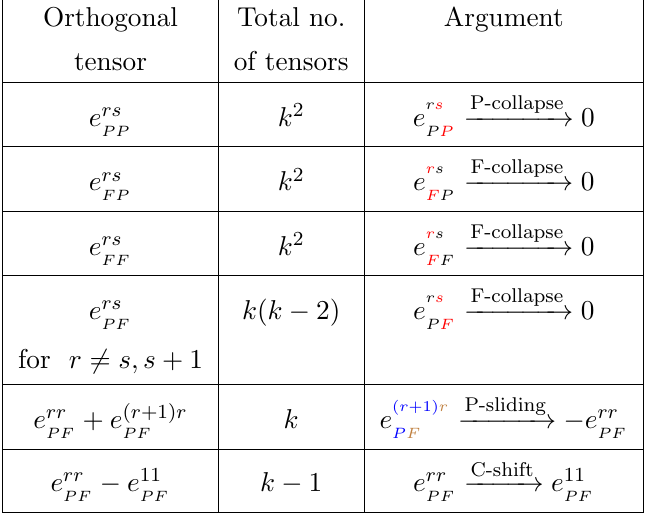
Table 1 . Arguments for the tensors orthogonal to the array of 2 point contour